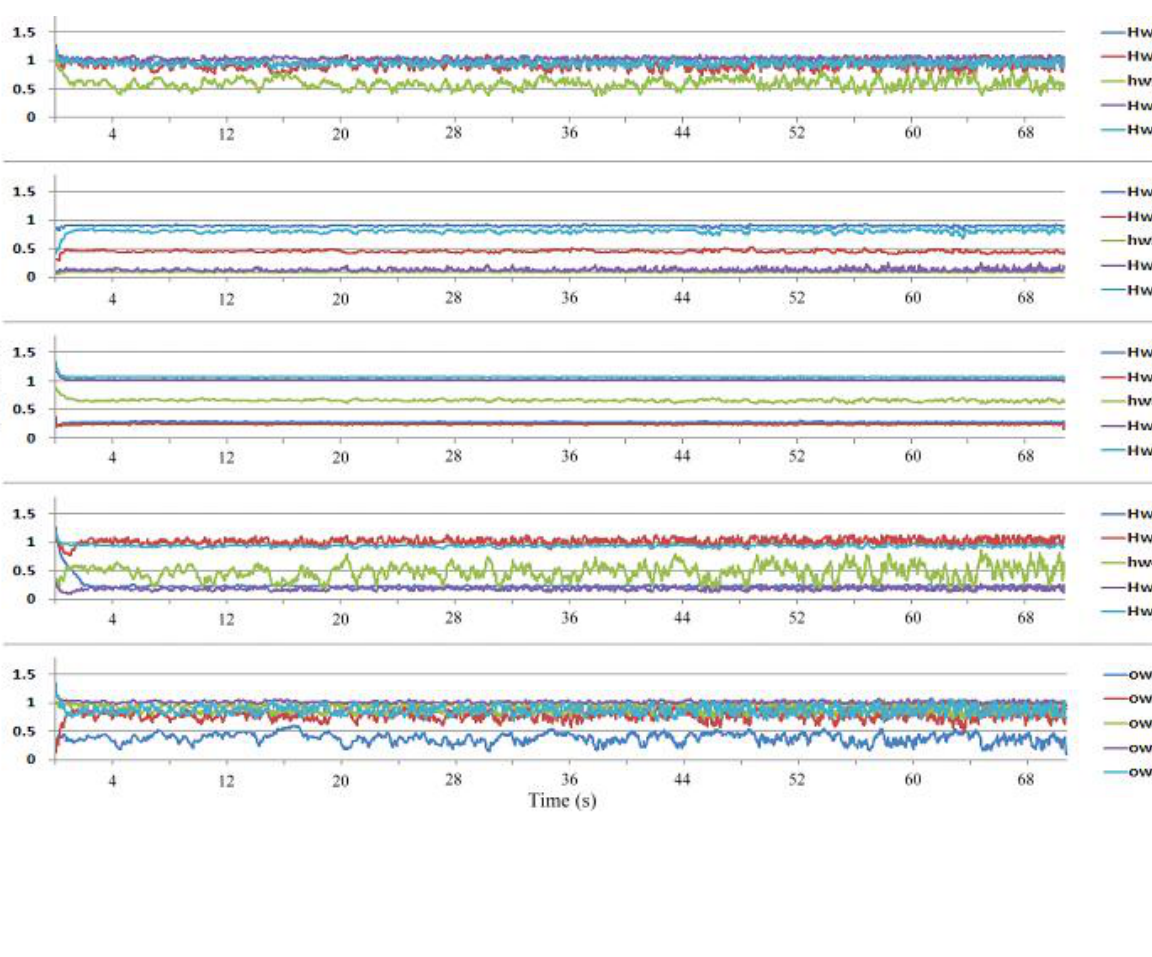
Figure 14. Weight change during